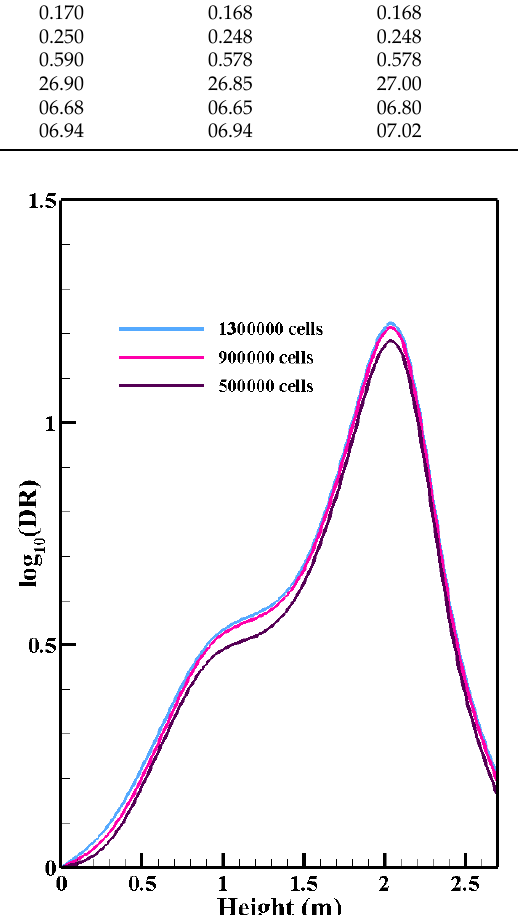
Table 2. Comparison of the velocity and temperature with the results of the study by Tao et al. [56]. Experimental Present Work Present Work Data (RSM) ( k– ε )